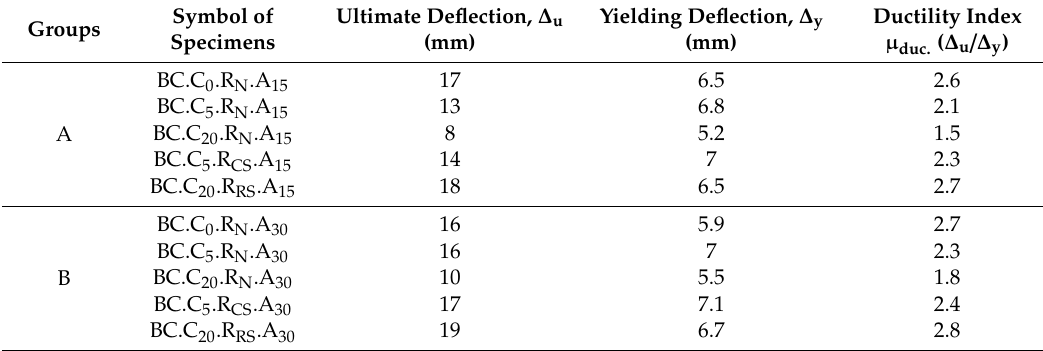
Table 4. Ductility index of tested